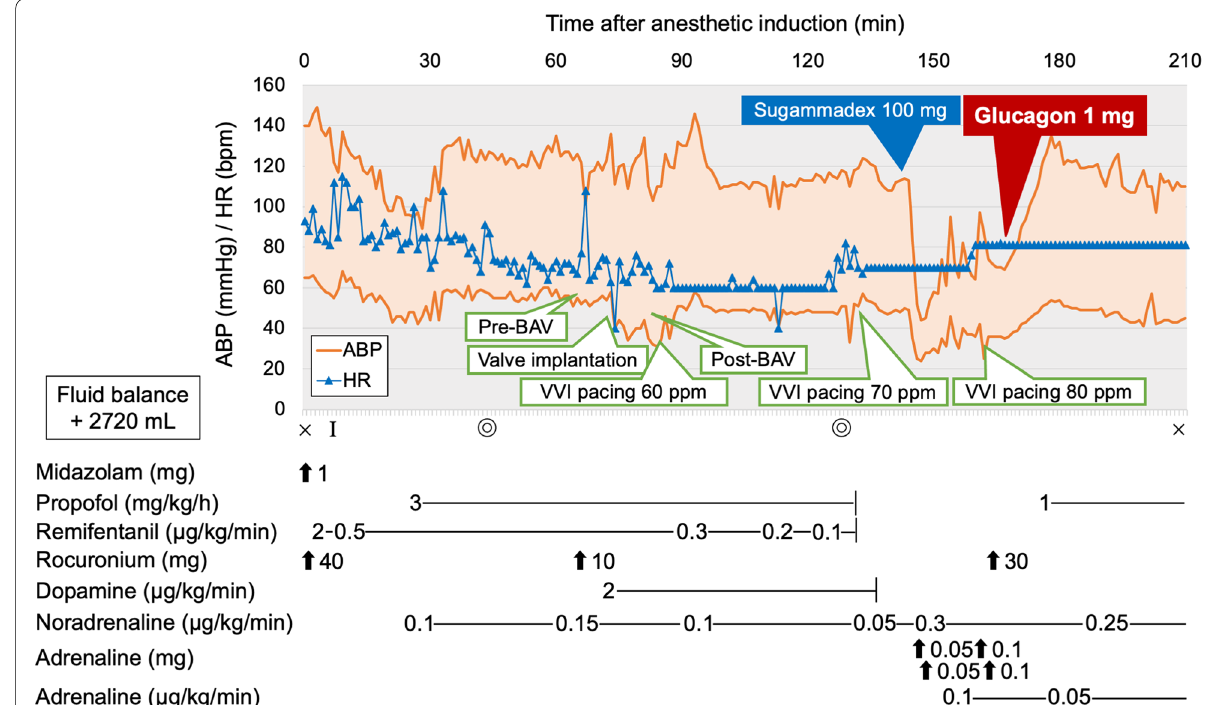
Fig. 1 Anesthesia record. beats per minute; BAV